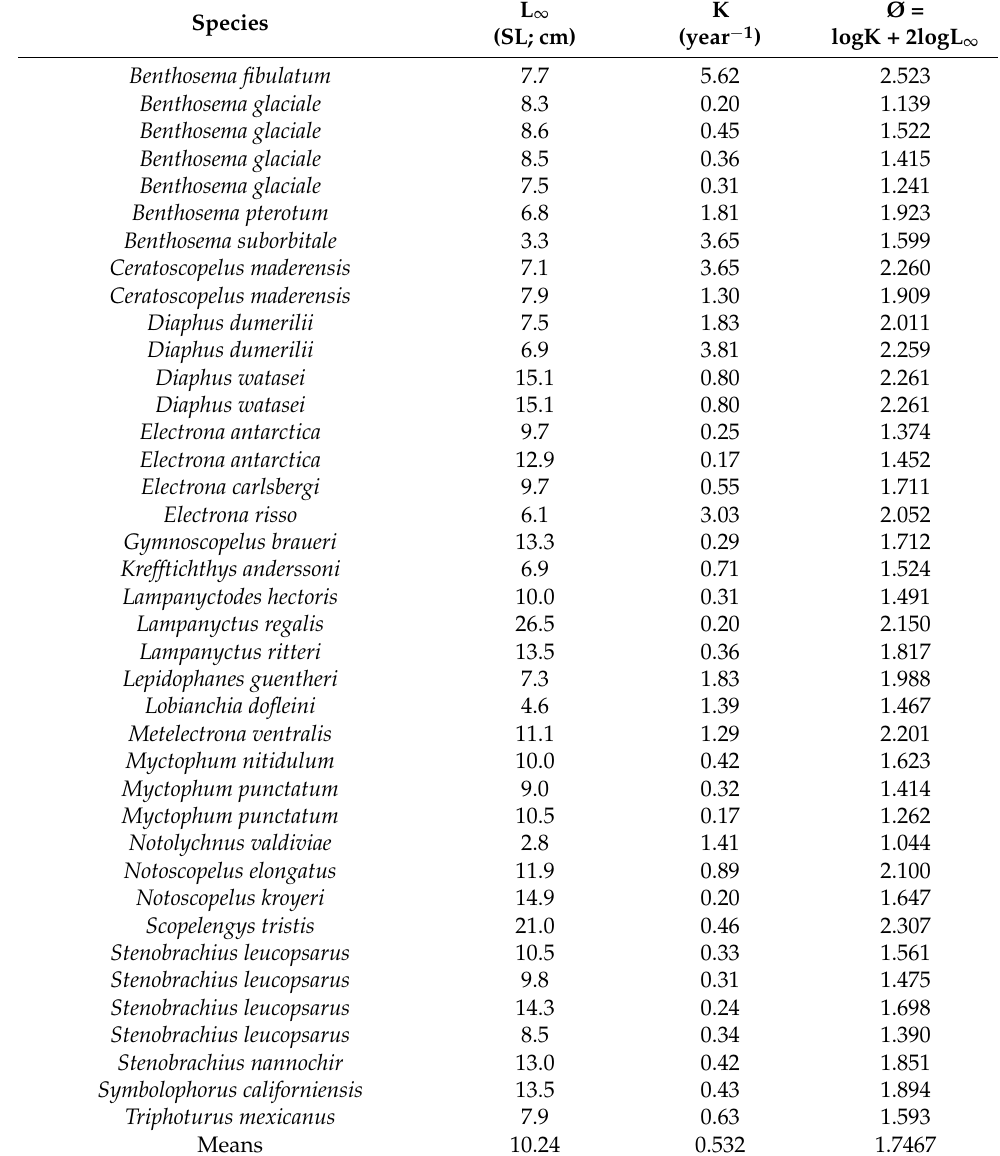
Table 1. Growth parameters of 39 populations of 28 mesopelagic species obtained from FishBase (www.fishbase.org; accessed on 8 June 2021), which provides details on ageing methods, sampling location, and sources not presented in this table. The mean growth coefficient (K) values were computed from the mean Ø and mean asymptotic length (L ∞ ) measured as standard length (SL).